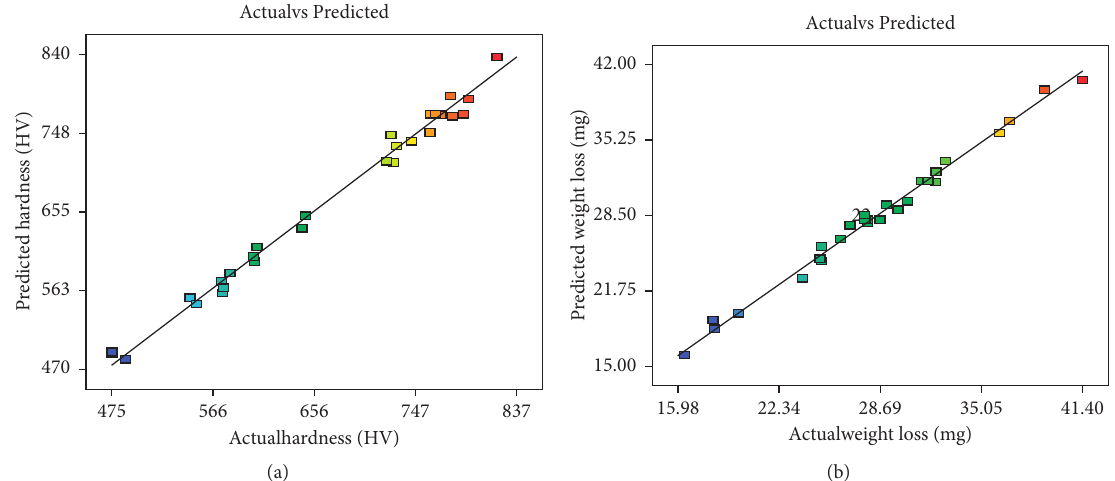
Figure 2: Correlation graphs. (a) Microhardness of deposit. (b) Weight loss of deposit.